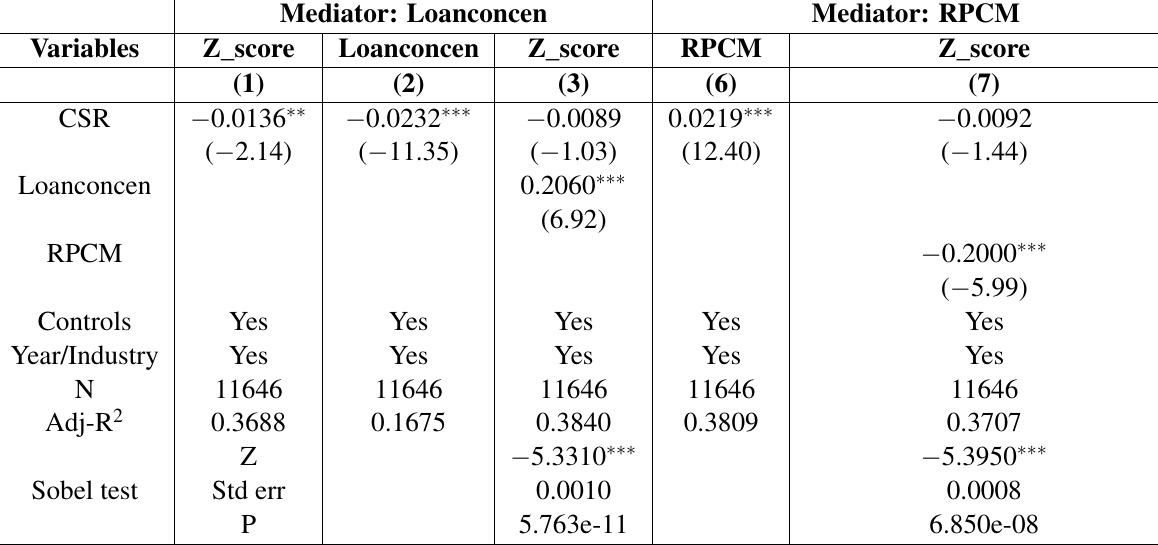
Table 8 Sample of private